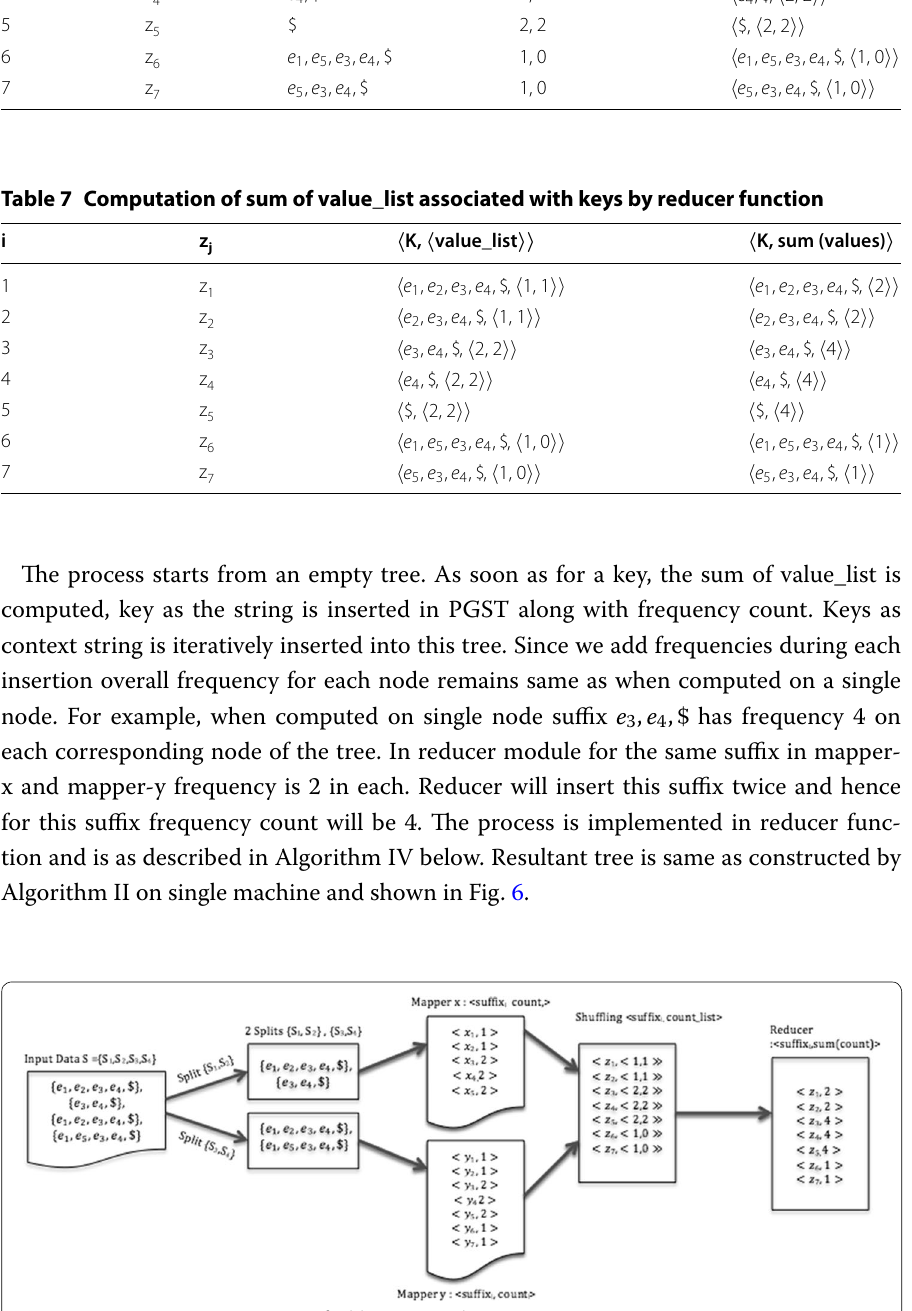
Fig. 5 Diagrammatic representation of Tables 4, 5, 6 and